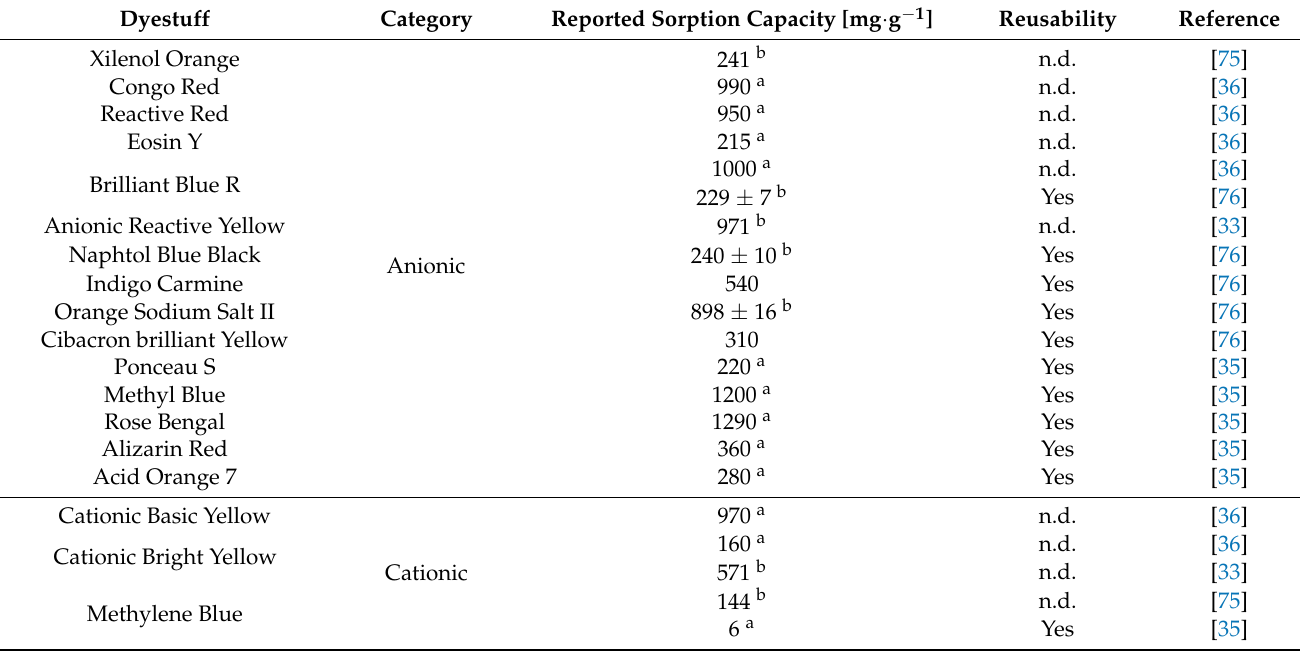
Table 3. Principal dye contaminants effectively sorbed by cellulose–PEI composites. The table shows the values of reported sorption capacity for each composite and its